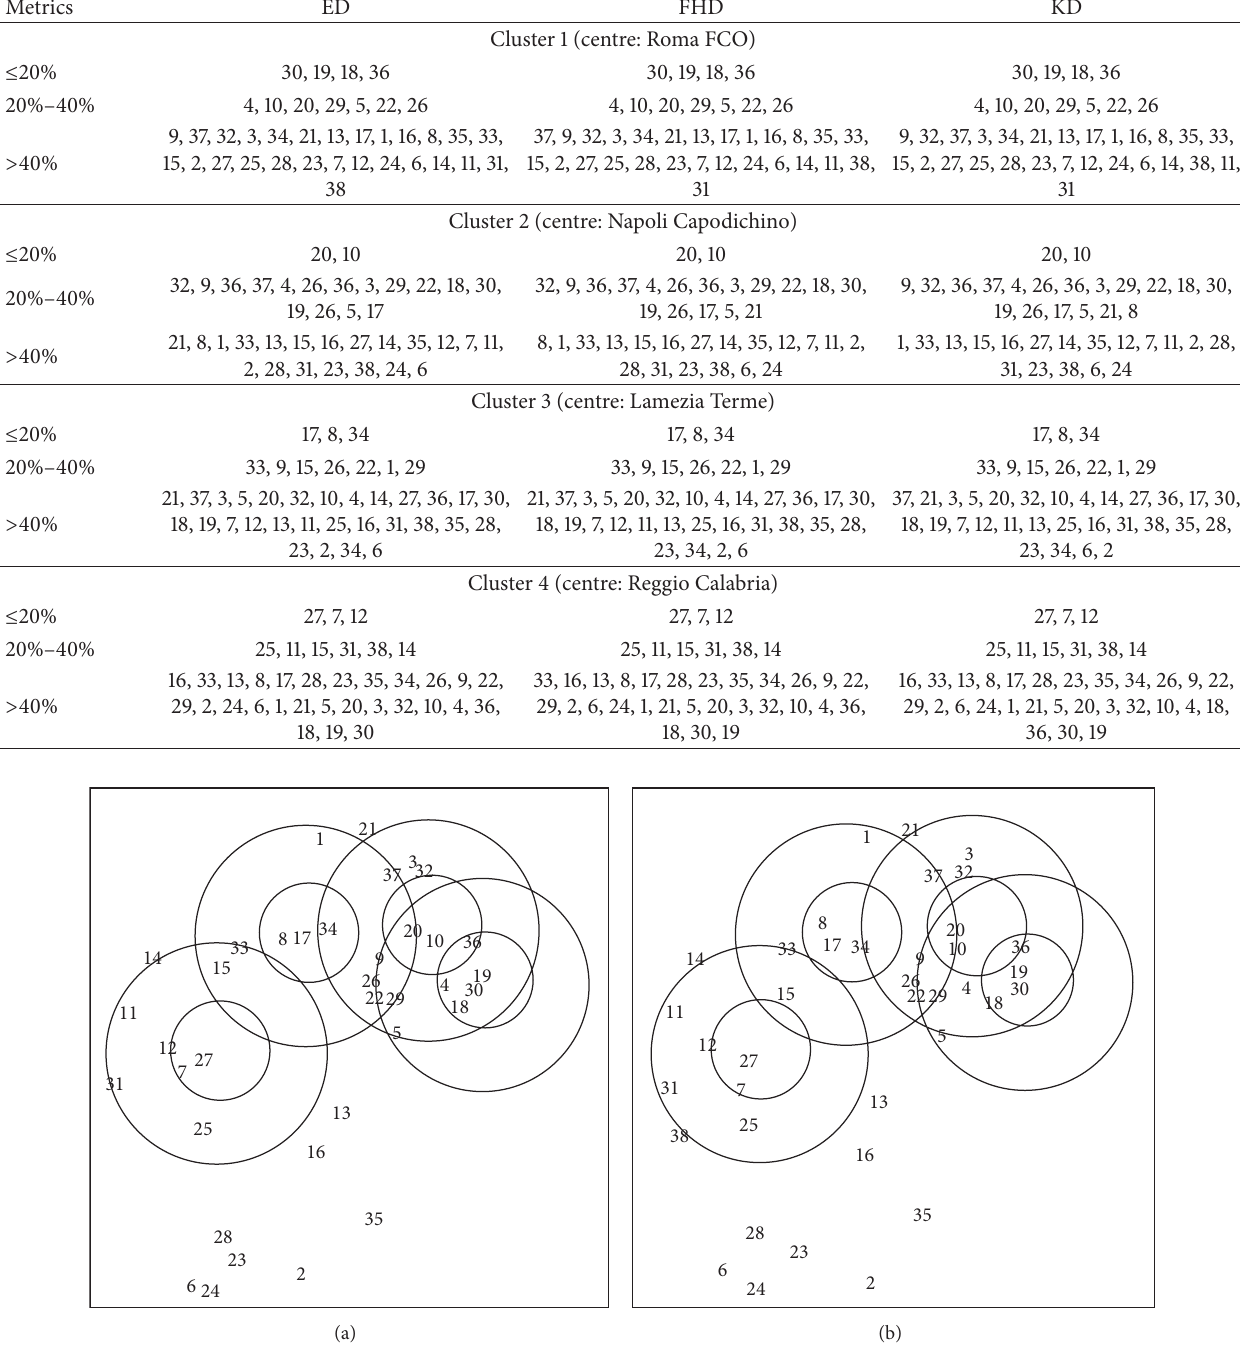
Table 5: Clustering results with prefixed number of clusters. Criterion: yearly movements.